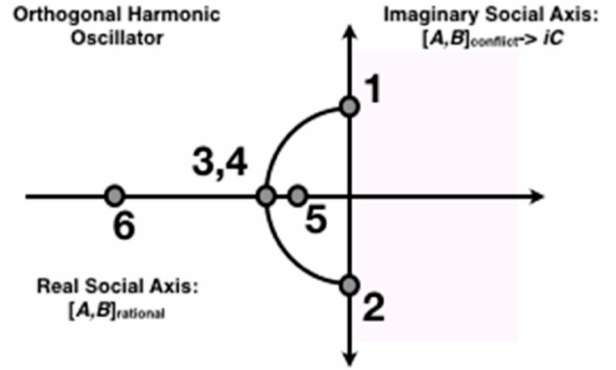
Figure 1. (From [71], submitted). The points (1 and 2) on the imaginary y -axis represent beliefs posed as choices to be debated for action. If no consensus for an agreement to take action is reached, no action occurs (e.g., the 7-year stalemate in the debate between DOE and NRC). Points 3 and 4 reflect a compromise choice for action on the x -axis (physical reality); points 5 and 6 represent resistance to the debaters that their audience has decided on the action it wants them to execute, with point 6 reflecting the strongest social feedback by the